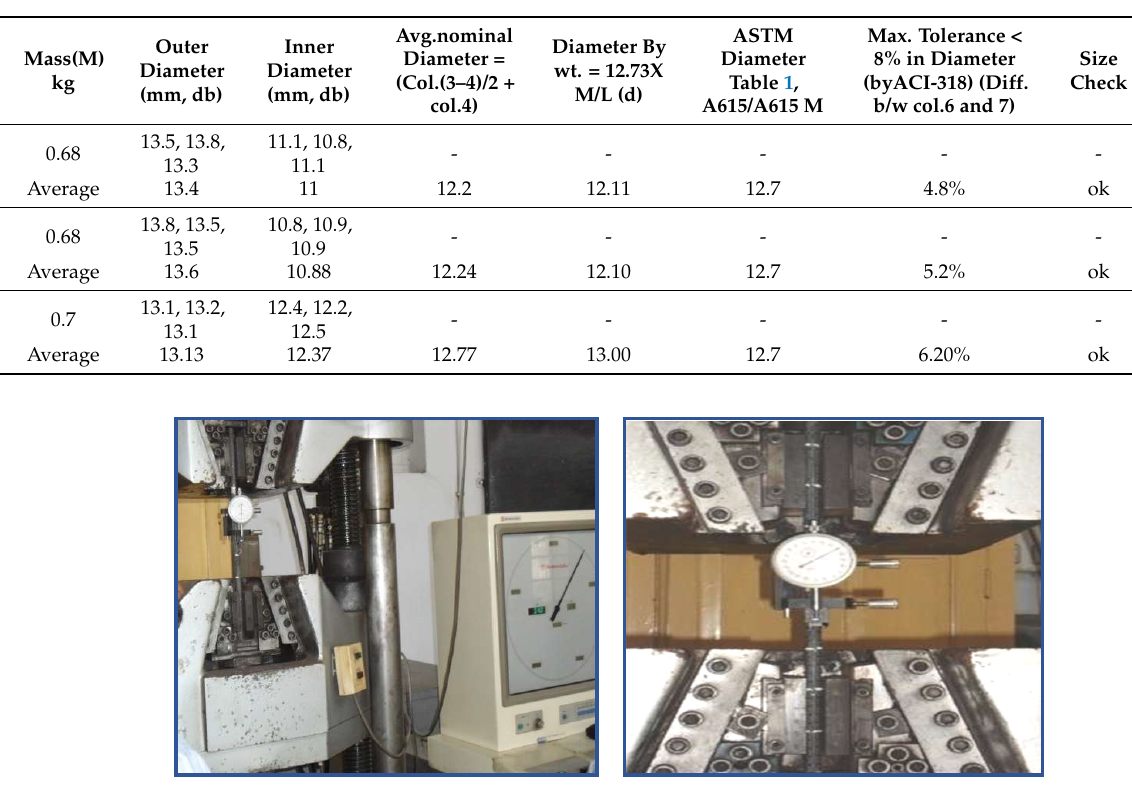
Table 5. Typical measurement for 13 mm rebar diameter.